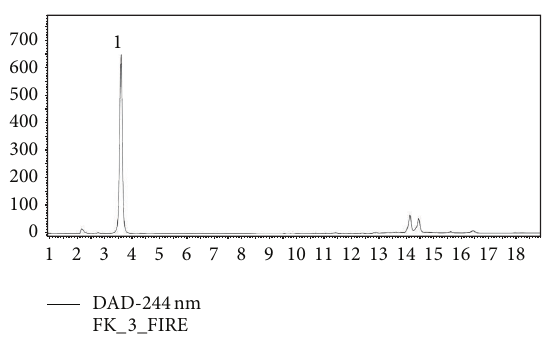
Figure 4: HPLC profile of vitamin C determination. The separation was performed on C18 Nautilus column with PDA detection at 244 nm. 1: L-ascorbic acid.